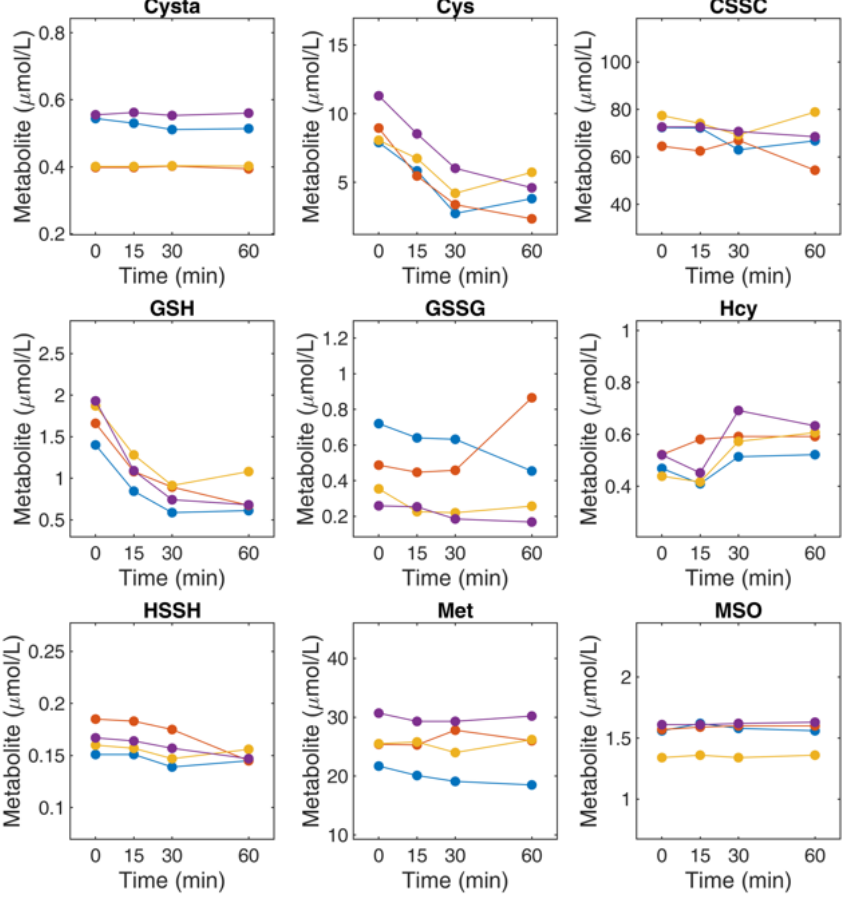
Figure 2. Stability of thiol and thioether metabolites in untreated human plasma. Metabolites were analysed immediately after blood-draw and plasma isolation (t = 0 min) and after 15, 30, and 60 min incubation of blood at room temperature. Cys and GSH underwent marked degradation over the course of this experiment. Table 3. Thiol and thioether metabolites and creatinine in commercial human and animal plasma. Metabolite ( µ mol /